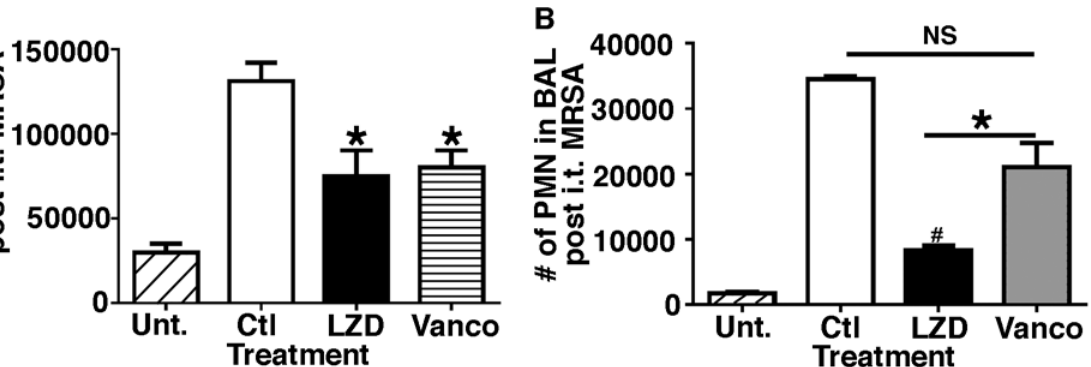
Figure 2. Mice treated with antibiotics have decreased total inflammatory cell influx as compared to saline treated animals; though LZD treated animals have lower number of neutrophils in BAL post bacterial challenge. WT mice were infected with H1N1 100 pfu i.n. and on day 7 challenged with 5×10 7 cfu cMRSA i.t., infected mice were treated with either vehicle or antibiotics LZD (80mg/kg i.p.) or Vanco (110 mg/kg i.p.). BAL was performed 24 hours post bacterial challenge and total inflammatory cells quantitated using a hemocytometer (Fig. 2A) and neutrophils quantitated post cytospin (Fig. 2B). n = 6 in each group, experiments repeated thrice. * p < 0.05, #p < 0.01 as compared to vehicle treated group. Error bars represent mean (cid:2)